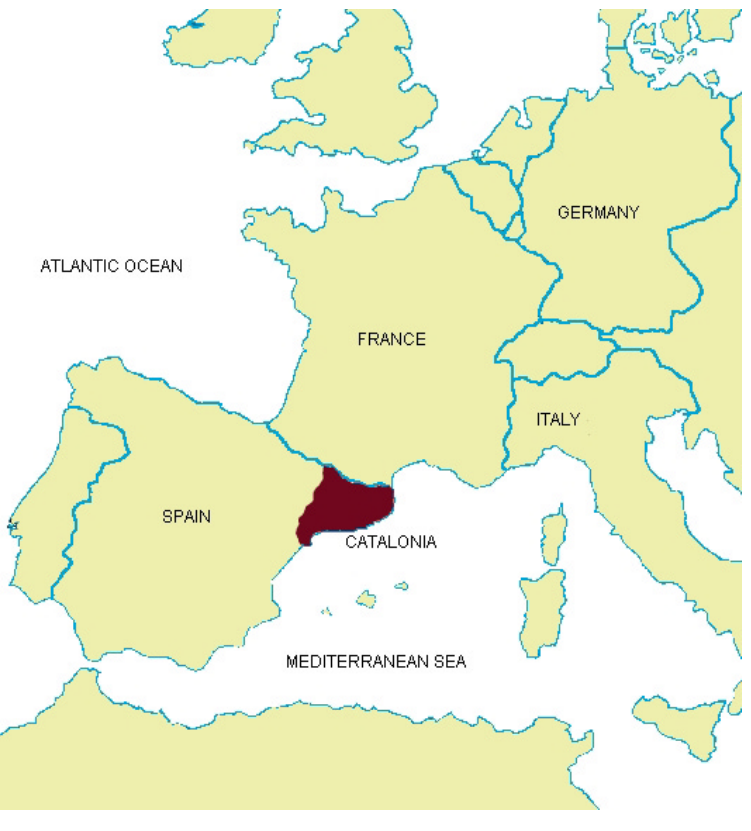
FIGURE 1. Geographical location of Catalonia in